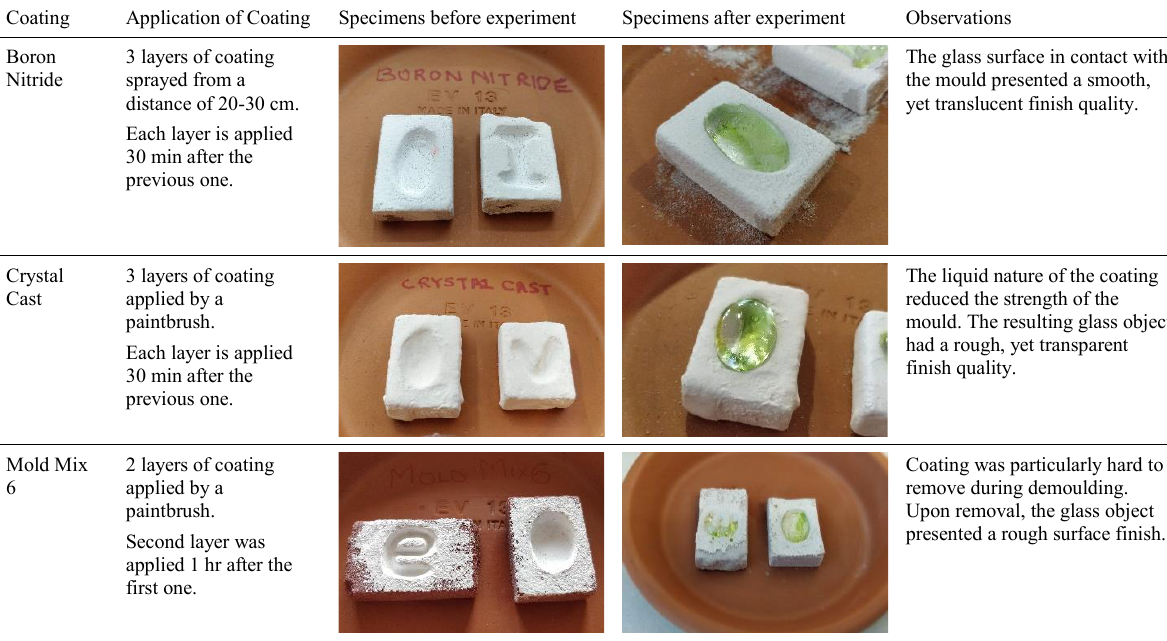
Table 5: Results of 3 rd Test Series.